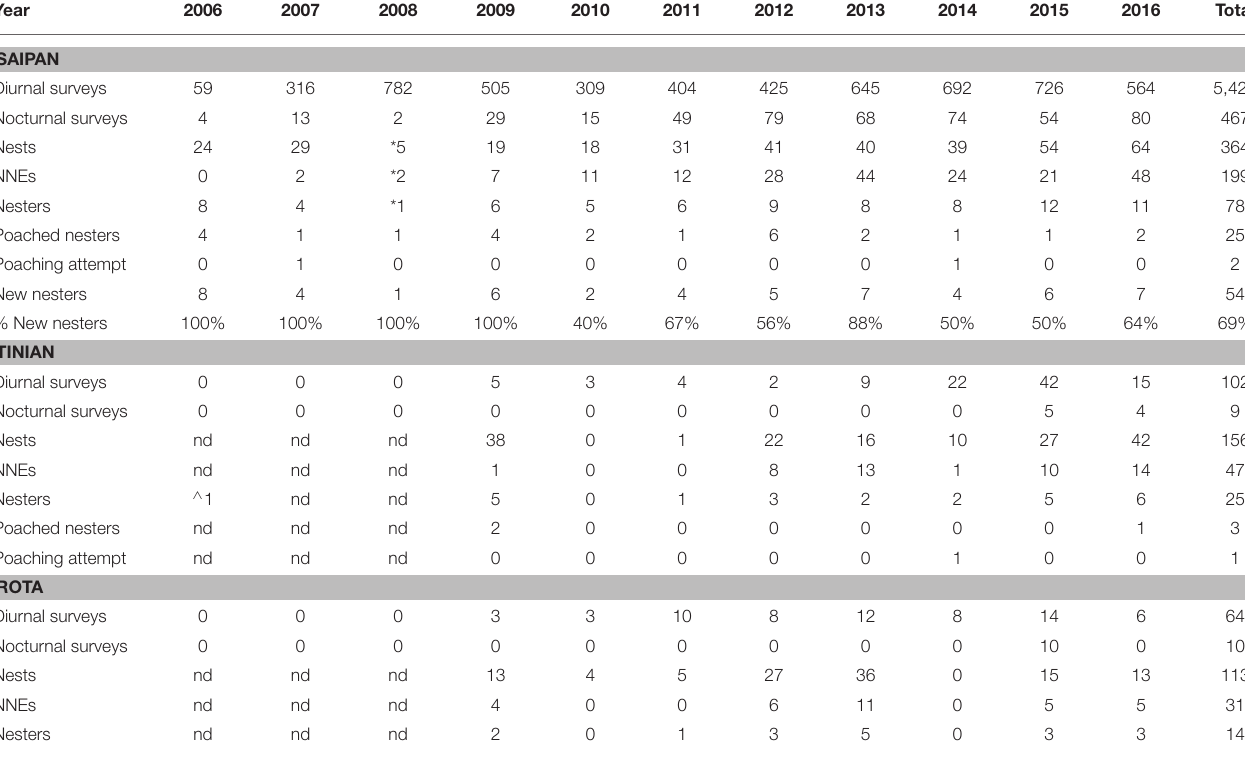
TABLE 1 | Summary of annual green turtle ( Chelonia mydas ) nesting activity on the islands of Saipan, Tinian, and Rota in the Commonwealth of the Northern Mariana Islands (CNMI),